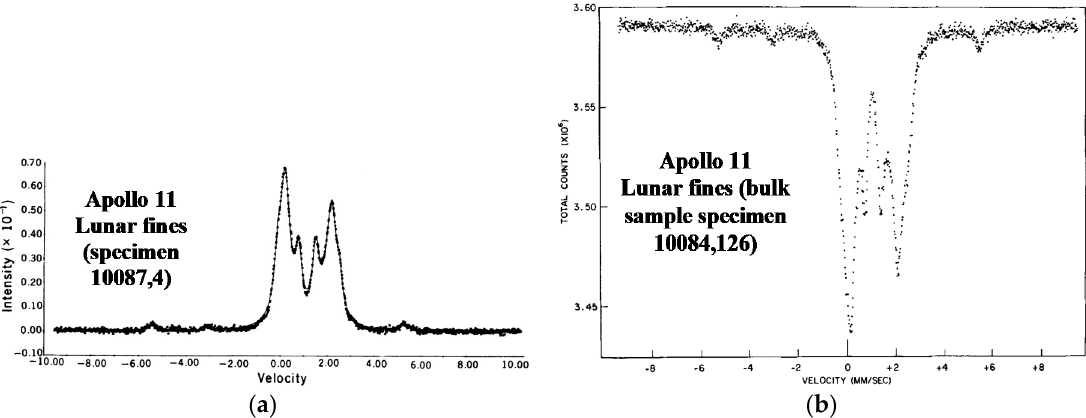
Figure 40. Mössbauer spectra of Lunar fines (Apollo 11) measured at room temperature: unsieved sample, specimen 10087,4 (backscattering geometry) ( a ) and specimen 10084,126, from the 140/170 sieve size fraction (transmission geometry) ( b ). Adapted from [101,103].